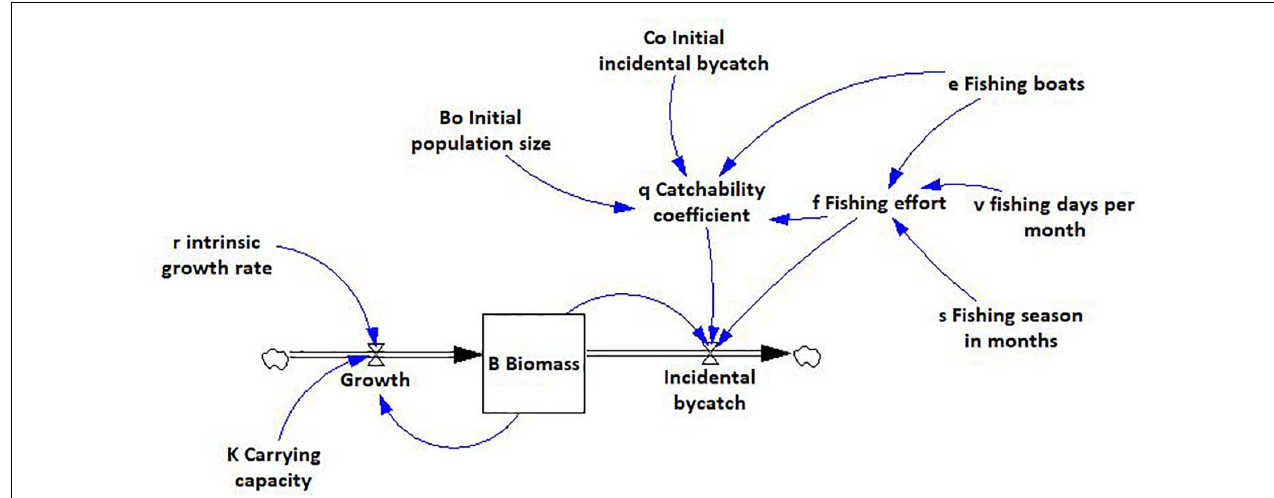
FIGURE 2 | System model of incidental bycatch of loggerhead turtles in the Gulf of Ulloa.